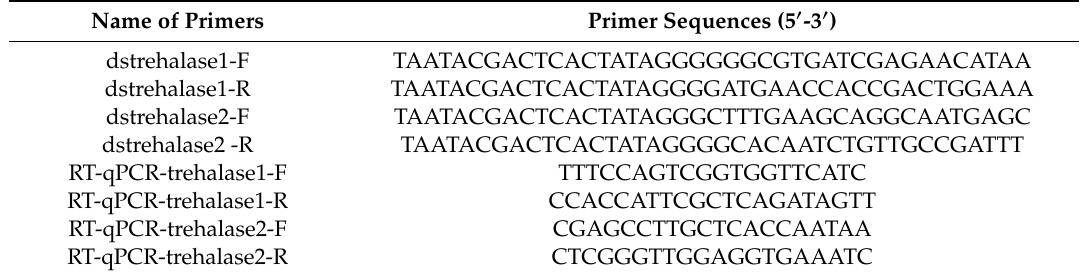
Table 3. Primers used in this